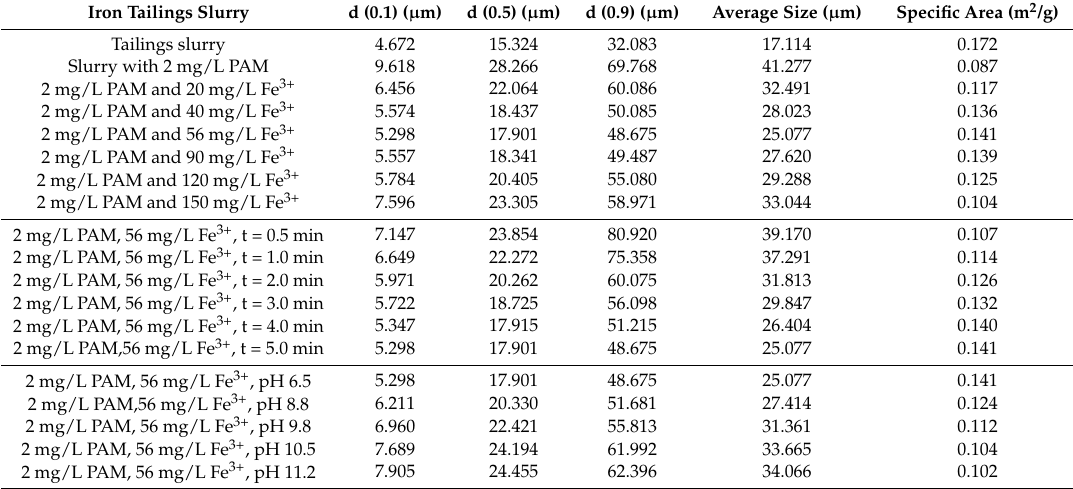
Table 2. Effect of Fe 3+ on the flocs’ size based on its regulating behavior.